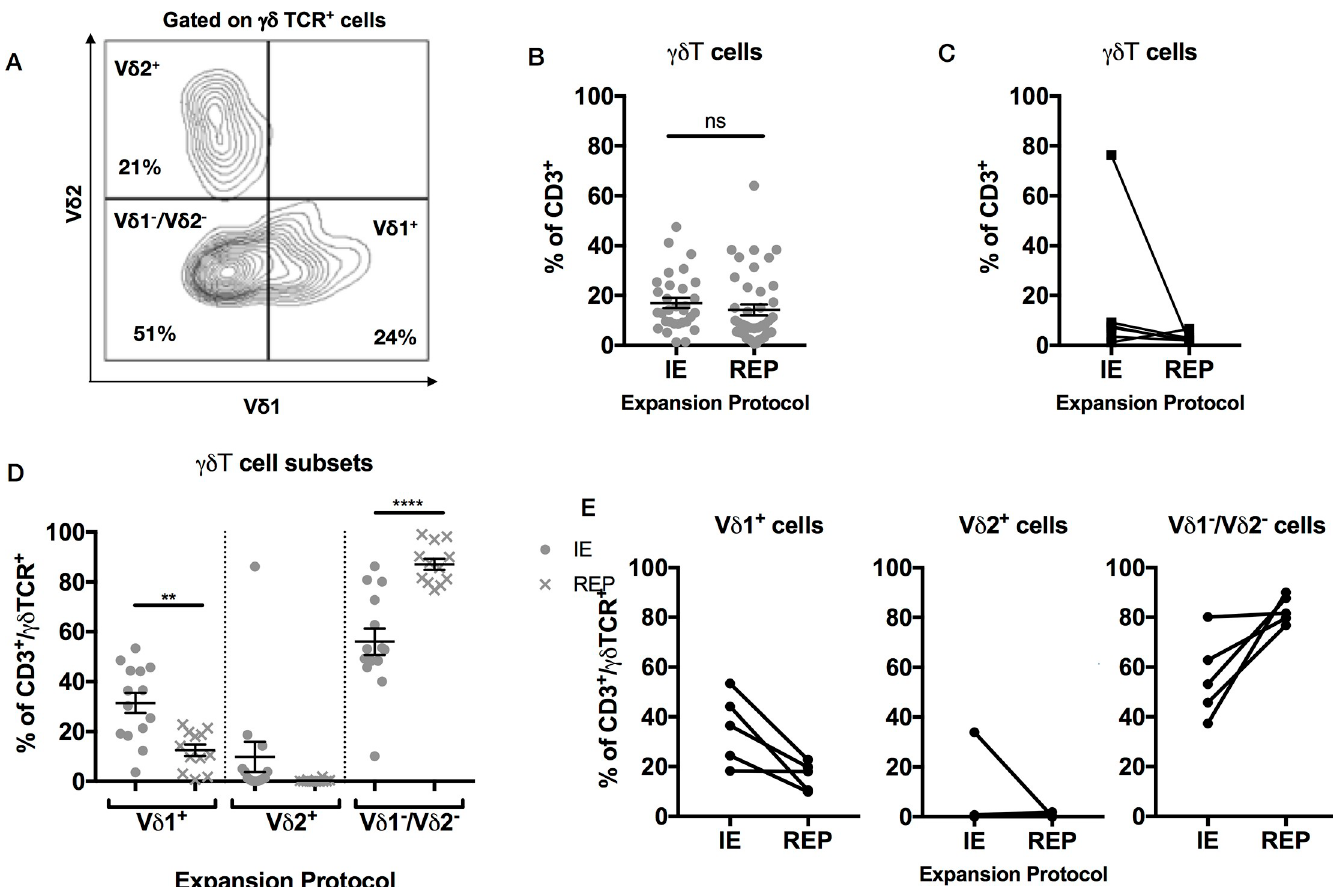
Fig 3. Innate lymphocyte subtype analysis within TILs population. (A) Gating strategy for identification of γδ T cells subtypes after gating on CD3 and γδ TCR positive cells. This representative example is from a TIL sample following initial 14-day expansion. (B) γδ T cell numbers expressed as % of CD3 + cells in TILs following initial expansion (n = 31) and then after REP (n = 41): statistical analysis by unpaired t-test. (C) γδ T cell numbers expressed as % of CD3 + cells in 6 paired TIL samples following initial expansion and then after REP. (D) γδ T cell subset distributions in the TILs population defined as in (A) following initial expansion (n = 14) and then after REP (n = 12). V δ 1 + cell proportions fell significantly (p = 0.006) and V δ 1 - /V δ 2 - proportions rose significantly after REP (p = < 0.0001): statistical comparison by one-way ANOVA with Sidak’s correction for multiple comparisons. (E) γδ T cell subset distributions in 5 paired TILs populations defined as in (A) following initial expansion and then after